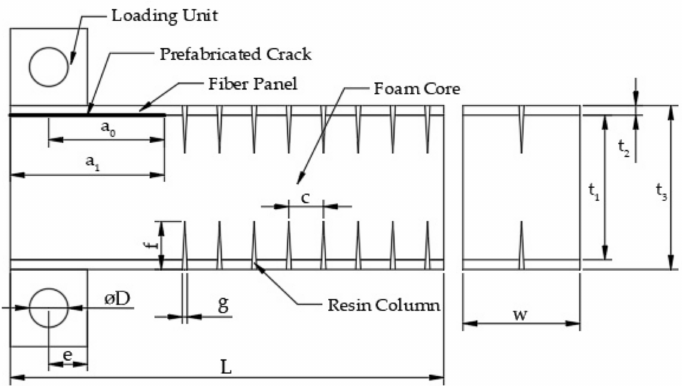
Figure 4. GFRP/foam sandwich composite specimens with prefabricated cracks for CSB